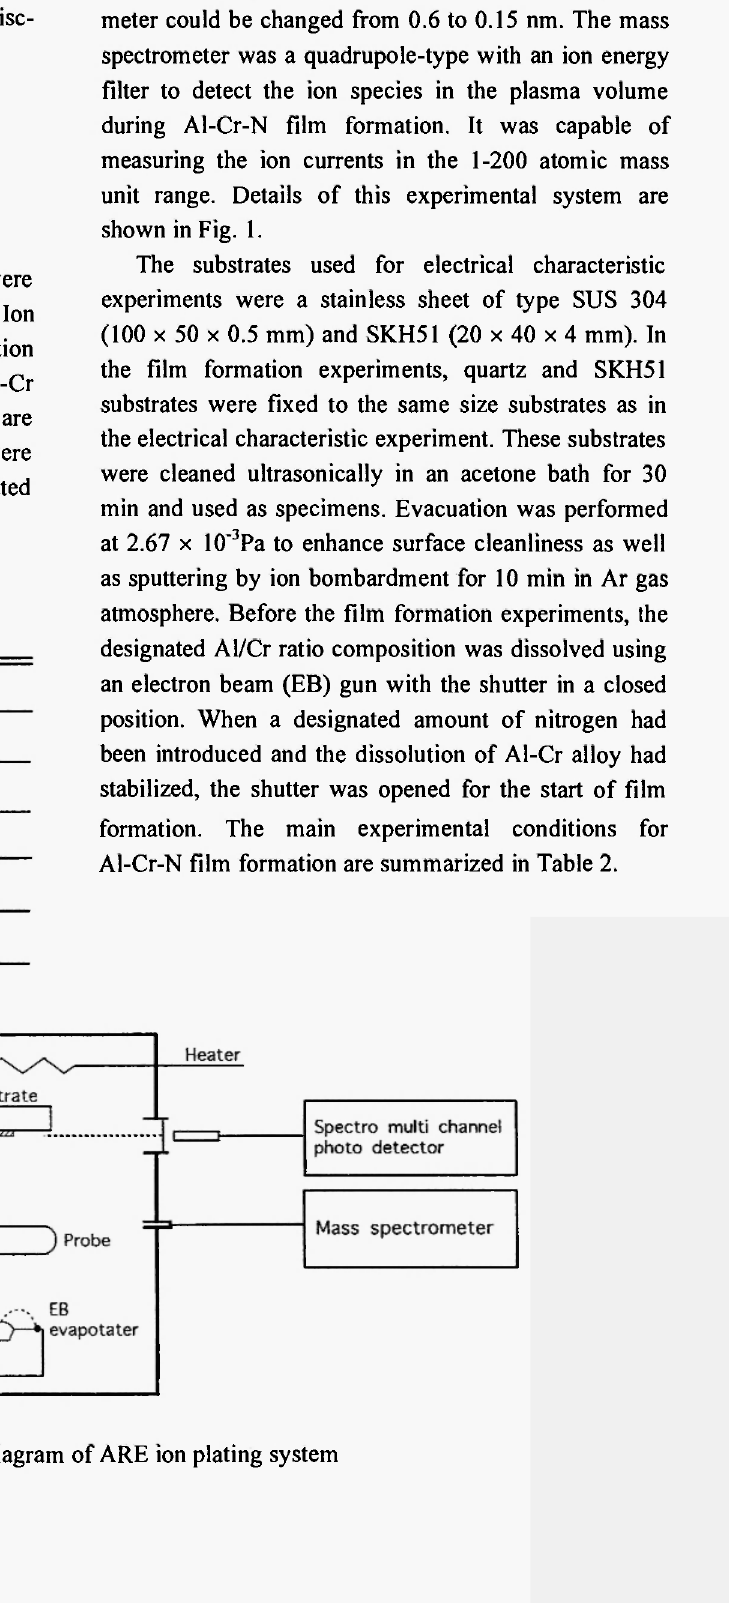
Fig. 1: Schematic diagram of ARE ion plating